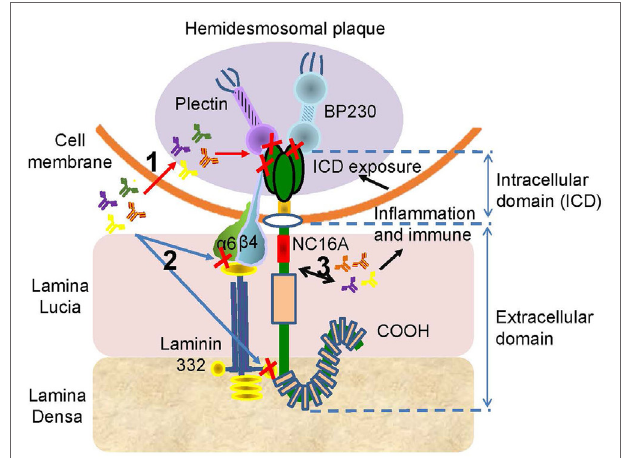
FigURe 4 | The potential pathogenesis of the anti-BP180 autoantibodies targeting the intracellular domain (ICD) or the ectodomain outside the NC16A. There are three possible mechanism associated the autoantibodies with ICD or ectodomain. (1) The autoantibodies penetrate cells, reach the ICD, and inhibit the interaction of BP180 with plectin, BP230, or β 4. (2) The binding of autoantibodies with ectodomain interferes the interplay of BP180, α 6, β 4, and laminin-332. (3) The interaction between autoantibodies and ectodomain induces inflammatory and immune responses, which lead to the exposure of the ICD, initiating the effect of autoantibodies on